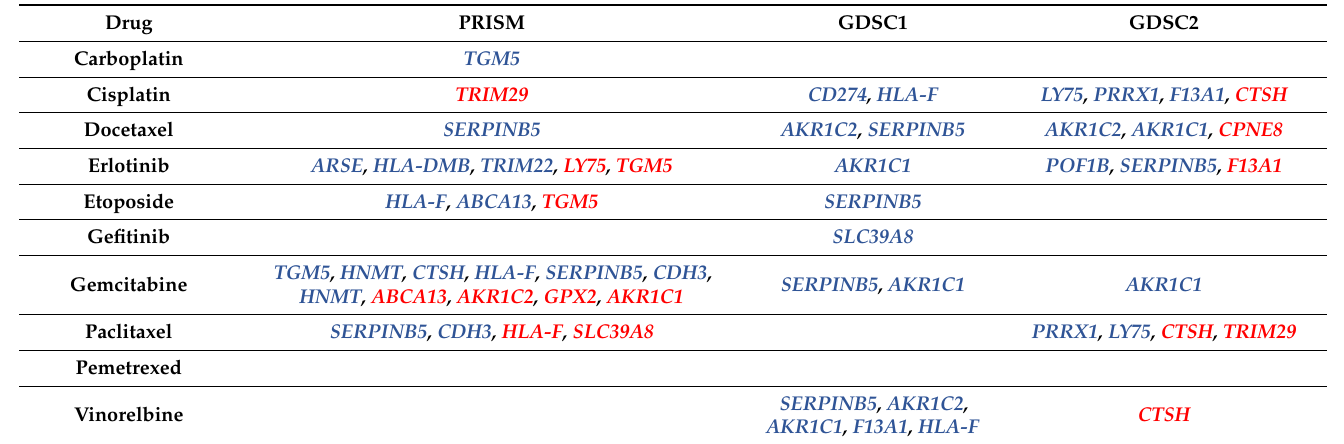
Table 2. Genes (shown in Figure 1C) with a significant differential protein expression ( p < 0.05; two sample t -tests) and a fold change < 0.5 or >2 in sensitive versus resistant CCLE NSCLC cell lines ( n = 63) to the studied drugs. Blue font indicates higher protein expression in sensitive cell lines, and red font indicates higher protein expression in resistant cell